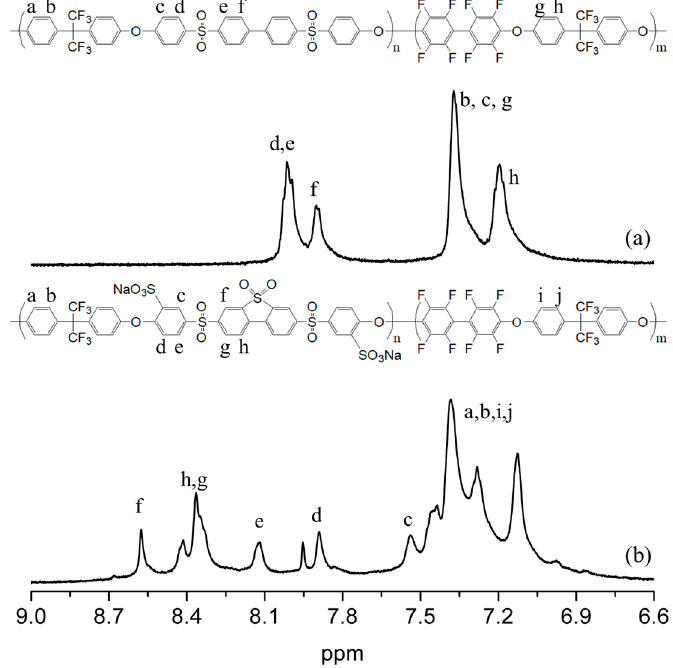
Figure 1. The proton signal of ( a ) poly(arylene biphenylether sulfone)-poly(arylene ether) (PABES-PAE) and ( b ) sulfonated poly(arylene biphenylether sulfone)-poly(arylene ether) (SPABES-PAE, 2:1) block copolymer.